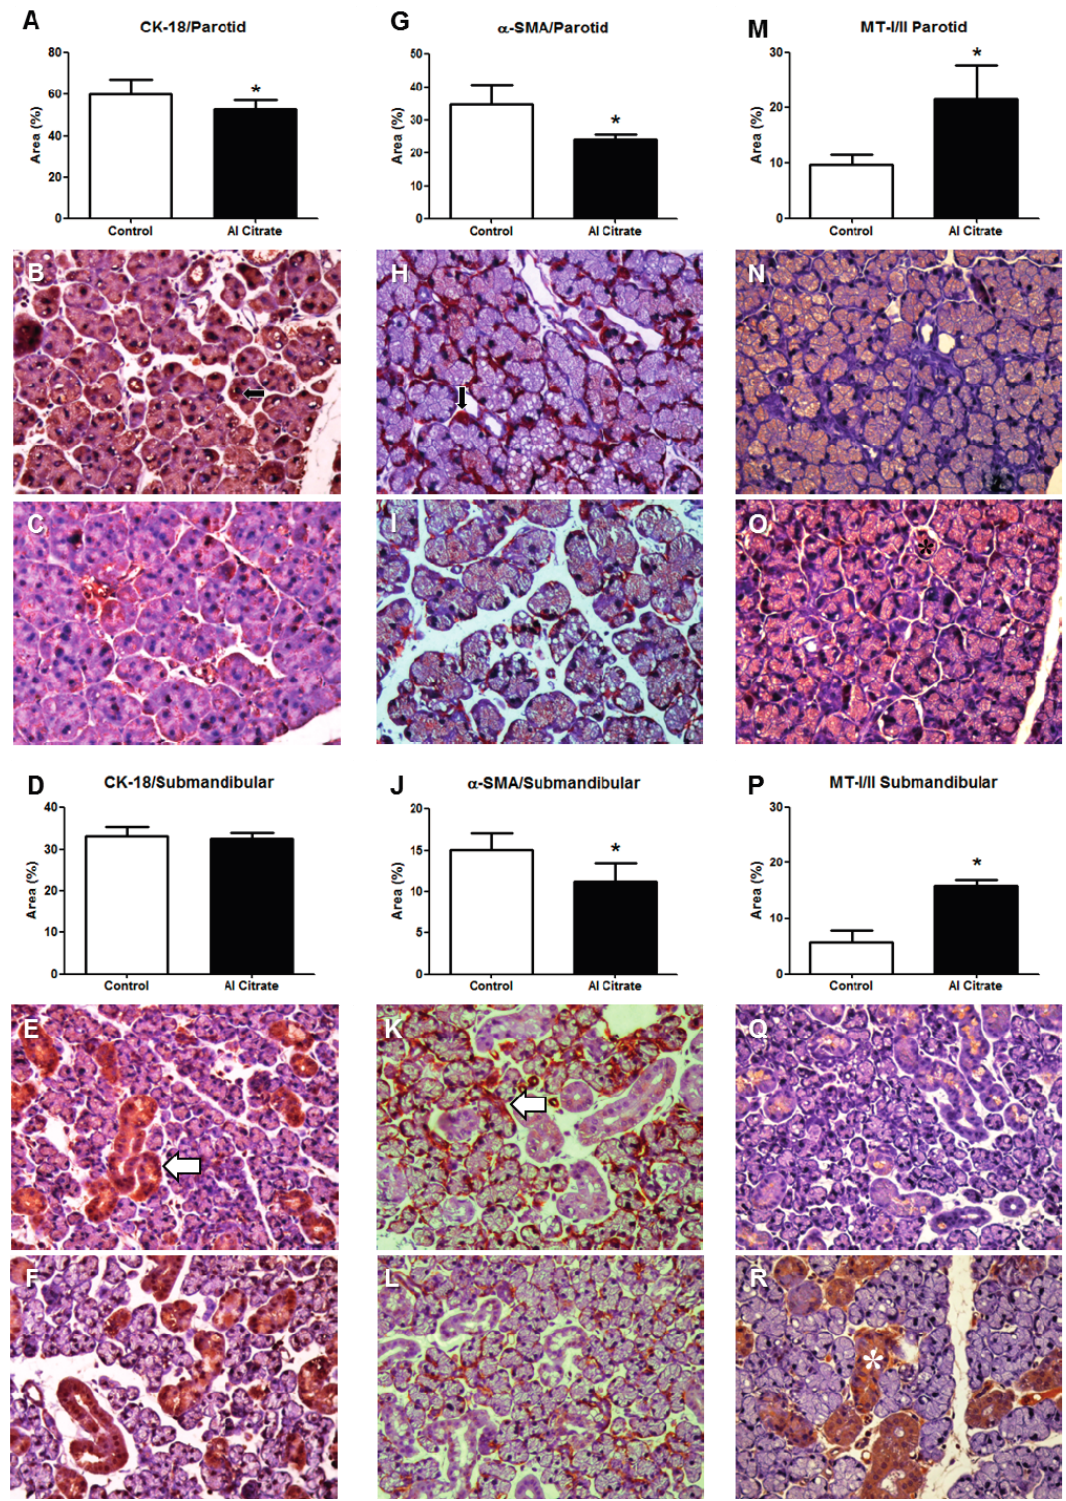
Figure 1. ( A ) – ( C ): CK-18 in the parotid; ( D ) – ( F ): CK-18 in the submandibular; ( G ) – ( I ): α -SMA in the parotid; ( J ) – ( L ): α -SMA in the submandibular; ( M ) – ( O ): MT-I/I in the parotid; ( P ) – ( R ): MT-I/I in the submandibular. ( B ), ( E ), ( H ), ( K ), ( N ), and ( Q ): control. ( C ), ( F ), ( I ), ( L ), ( O ), ( R ): exposed to Al citrate. Arrows and asterisks indicate immunohistochemical